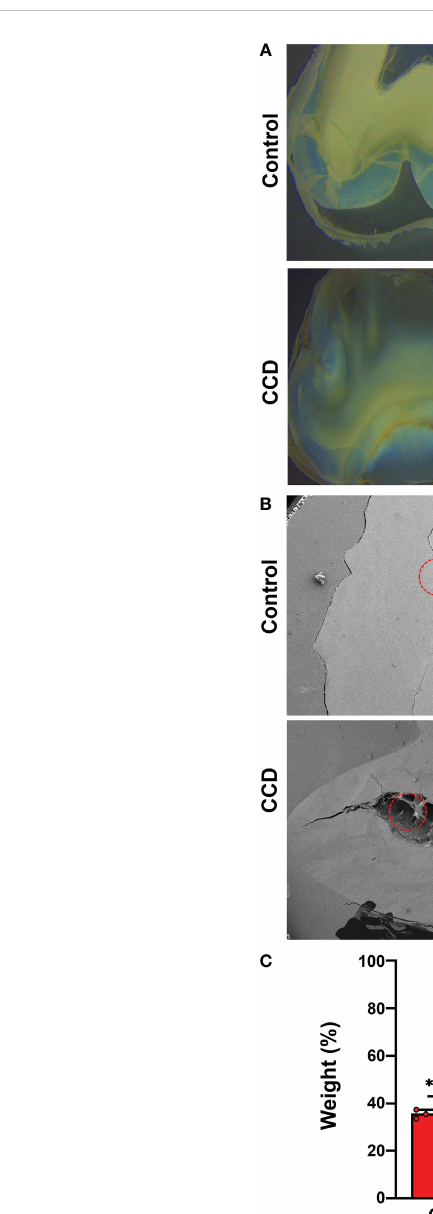
lower protein expression levels after 14 d of osteogenic induction (Figure 6D). Finally, Oil Red O Staining was performed to detect the adipogenic differentiation capacity of the two groups. The fi ndings showed that the CCD group possessed higher adipogenesis potential than the control group, with more lipid droplet formation and higher expression levels of the adipogenic genes LPL and PPAR- g (**p < 0.01) (Figures 6E, F). These fi ndings reveal that SHED from the CCD group exhibited impaired osteogenic potential but enhanced adipogenic potential, implying that the mutant of RUNX2 may affect the osteogenic potential of SHED.